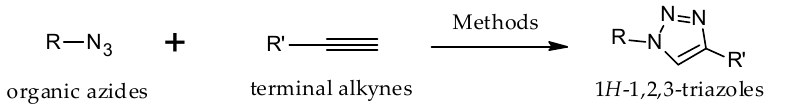
Figure 2. 1 H -1,2,3-Triazole derivatives 1 – 7 tested against ZIKV.